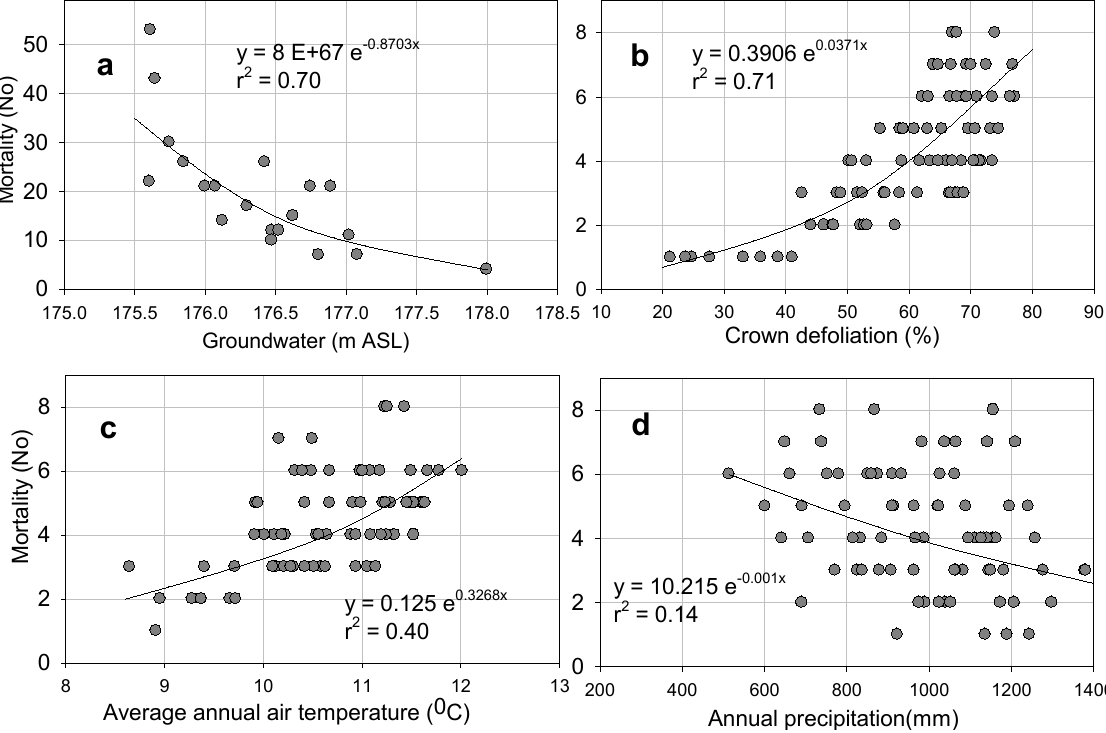
Figure 6. Comparison between cumulative mortality and average groundwater ( a ); between annual mortality and annual crown defoliation ( b ) (1995–2014); between mortality and average annual air temperature ( c ) and between mortality and annual precipitation ( d